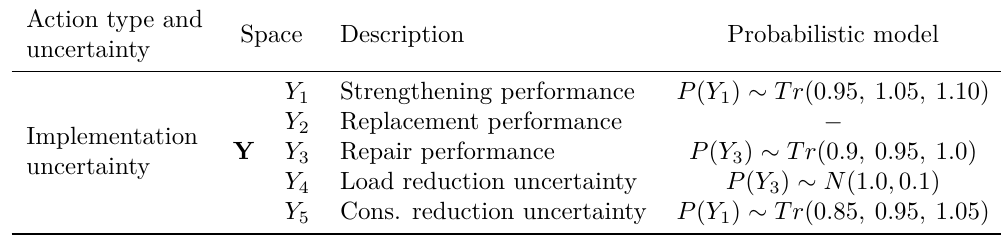
Table 3. Action uncertainty